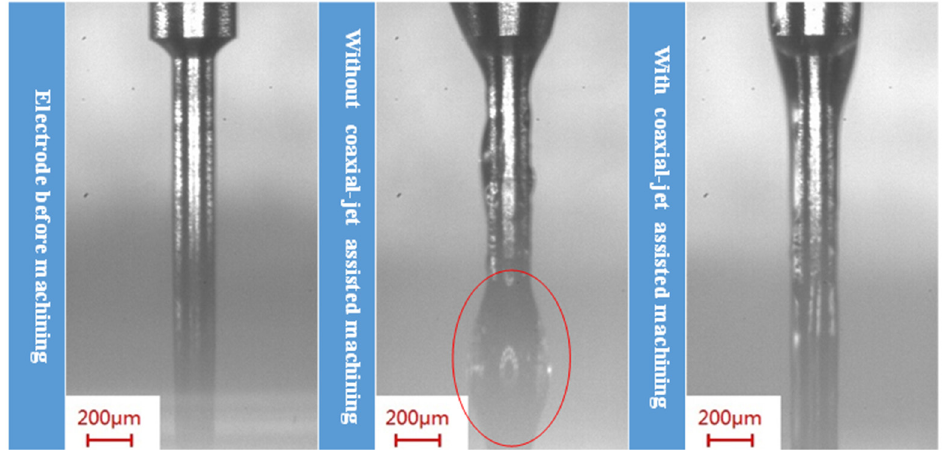
Figure 10. The coaxial jet-assisted method’s e ff ect of electrolyte removal from the electrode side wall during the machining process.